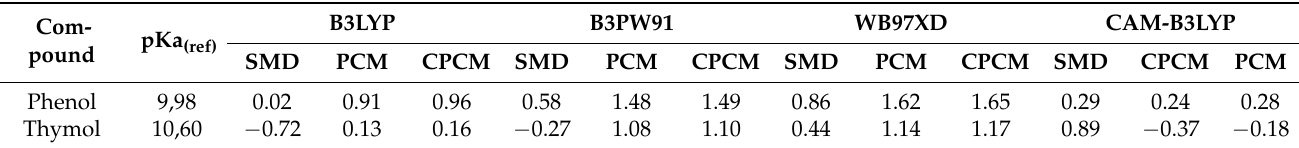
Table 3. ∆ pKa values calculated with two explicit water molecules. Table 3. Δ pKa values calculated with two explicit water molecules.